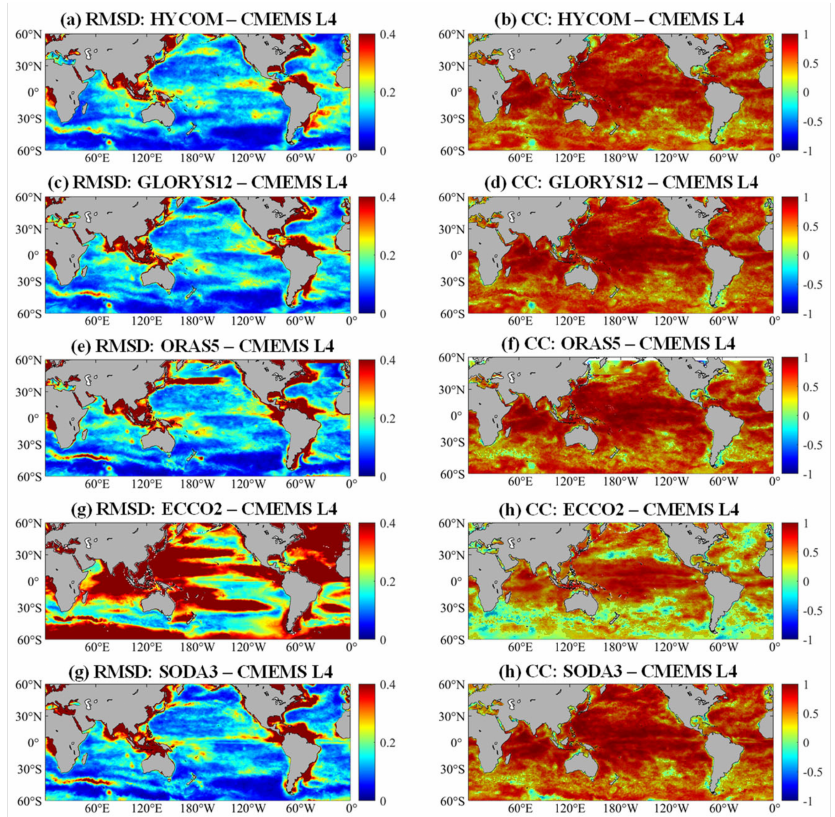
Figure 8. Comparison of RMSDs and correlation coefficients in five reanalysis SSS against the CMEMS L4 SSS product. The unit is in PSU for RMSD